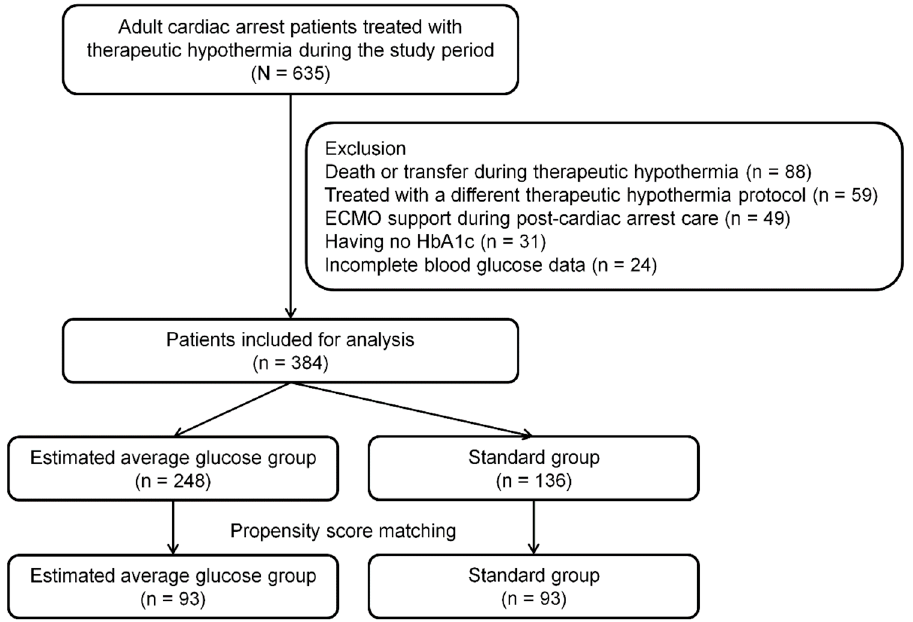
Figure 1. Diagram showing the number of included patients. ECMO, extracorporeal membrane oxygenation.